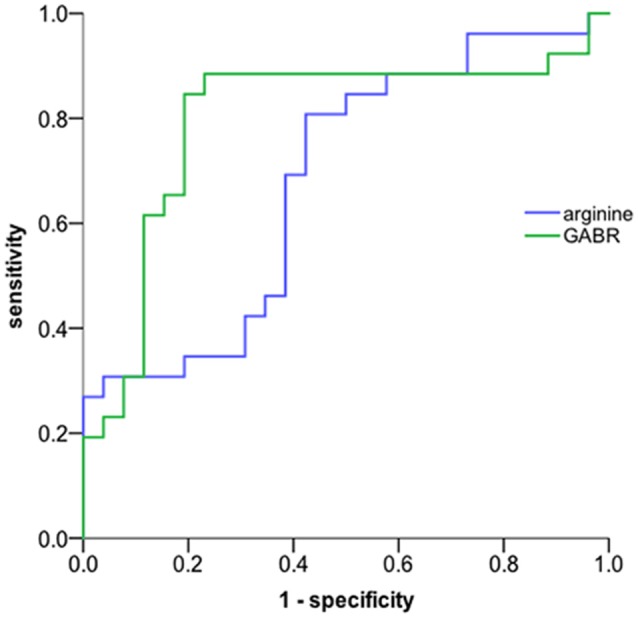
ROC curve. The global arginine bioavailability ratio (GABR) is a more sensitive diagnostic measurement compared to single concentration. The AUC of urine GABR and arginine for detection was 0.797and 0.682, respectively.